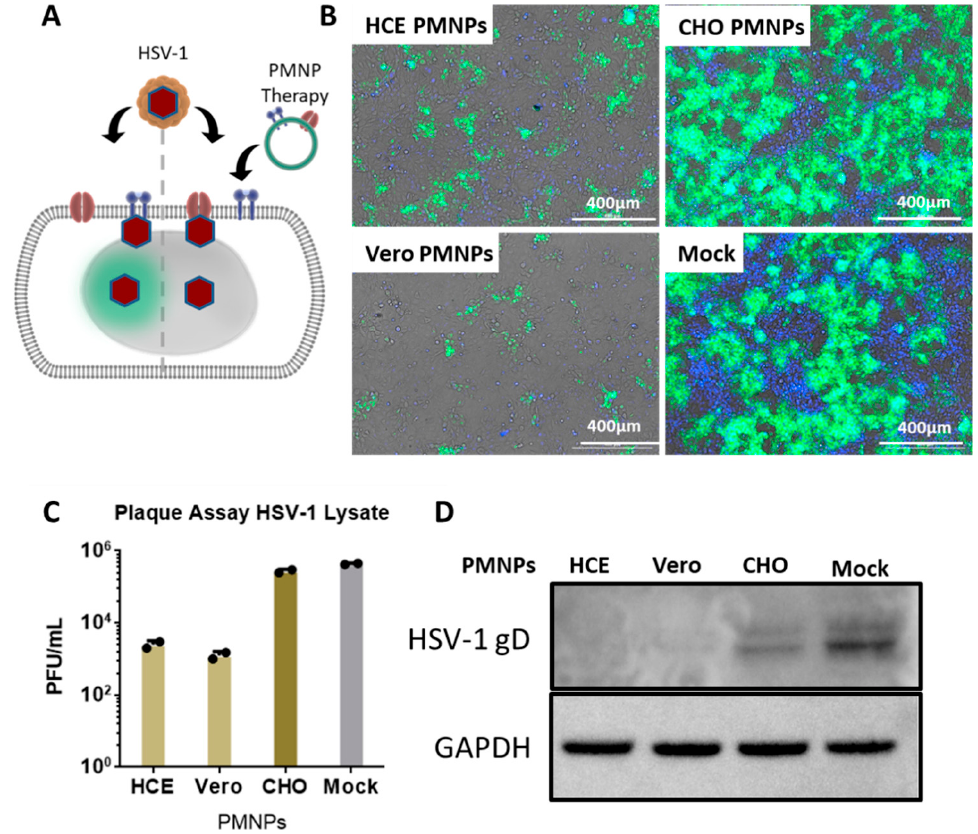
Figure 4. Effect of PMNP therapy of HSV-1 infection: ( A ) A schematic of the therapeutic treatment strategy employed for the experiments. Briefly, HCEs were infected with a GFP-producing reporter virus for 2 h. The media was then replaced with fresh media containing Vero or HCE-PMNPs at a concentration of 100 µ g/mL. The cells were incubated for a further 24 h, before ( B ) representative fluorescent images were captured. ( C ) Cell lysates were collected to perform a plaque assay, and the results indicate a reduction in infectious viral titer in samples therapeutically treated with HCE and Vero-PMNPs but not CHO-PMNPs. ( D ) Cell lysates were also used to perform a representative western blot to evaluate viral protein (HSV-1 glycoprotein D) synthesis.